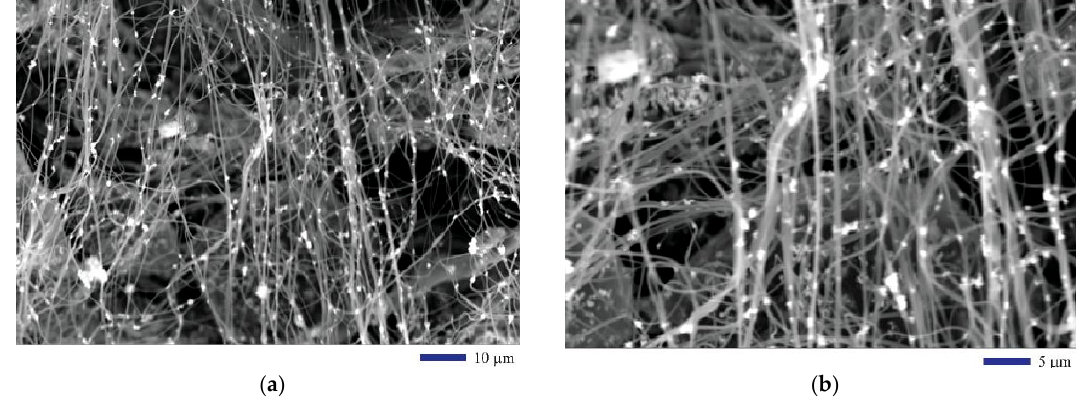
Figure 2. SEM images of the iron oxide nanoparticle-containing carbon fibers: ( a ) 1000×; ( b ) 2000×.